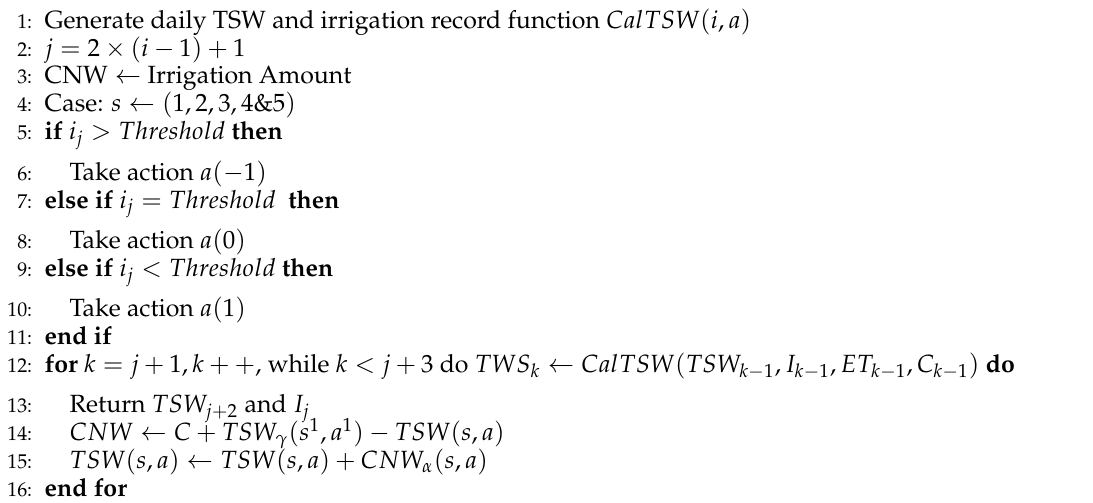
Algorithm 1 Generating daily TSW and record